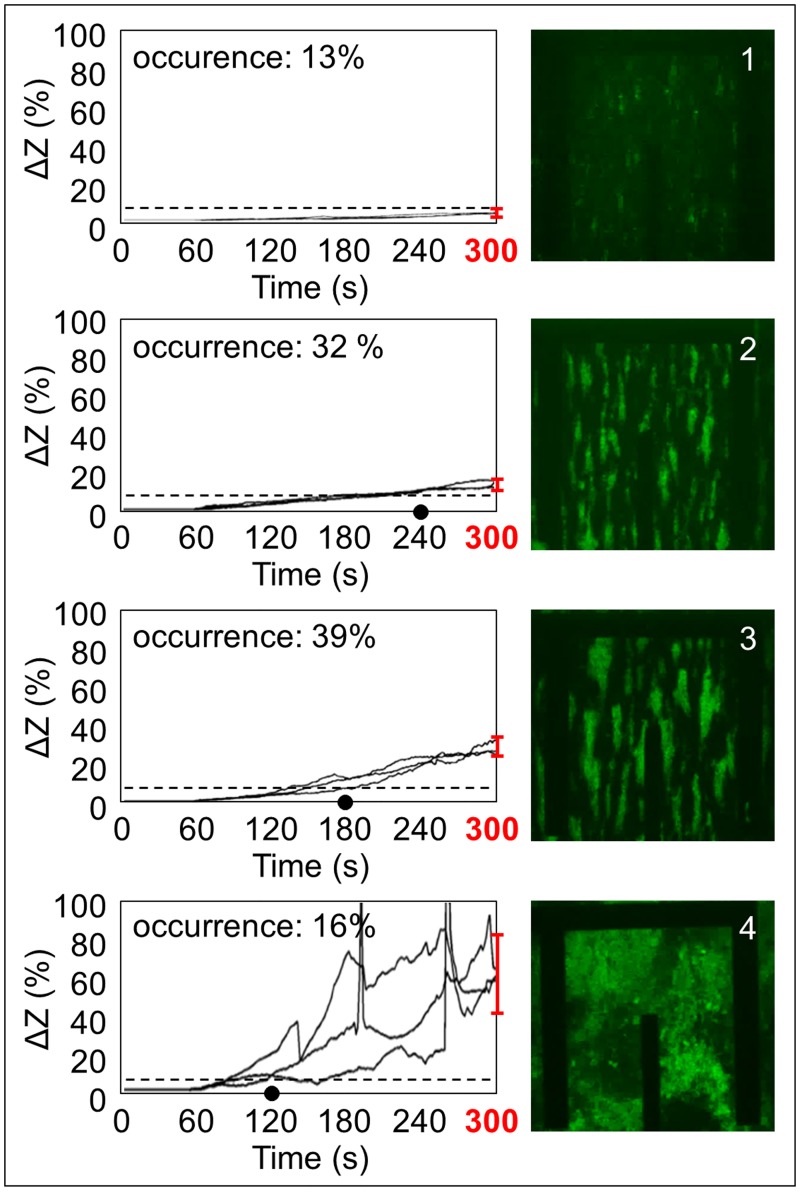
Classification of blood behavior.Classification of blood behavior in terms of platelet adhesion and aggregation, according to the variation of the impedance signal in time, expressed as relative increase over the initial value (ΔZ (%)). For each group, three representative signals of impedance variation (acquired in real-time during the perfusion) and a 2D image (acquired at t = 300 s) are shown as characteristic of the group. The red bars at t = 300 s show the percentage level of ΔZ overcome by all the signals of the related group within the end of perfusion (group 1: 7.55 ± 1.42%; group 2: 16.55 ± 1.88%; group 3: 31.15 ± 5.43%; group 4: 65.46 ± 20.12%). The dot on the time axis indicates the instant time at which all the signals of the group pass the 10% (dashed line) of impedance increase (group 1: signals do not overpass the 10% threshold within 300 seconds; group 2: dot at t = 240 s; group 3: dot at t = 180 s; group 4: dot at t = 120 s).